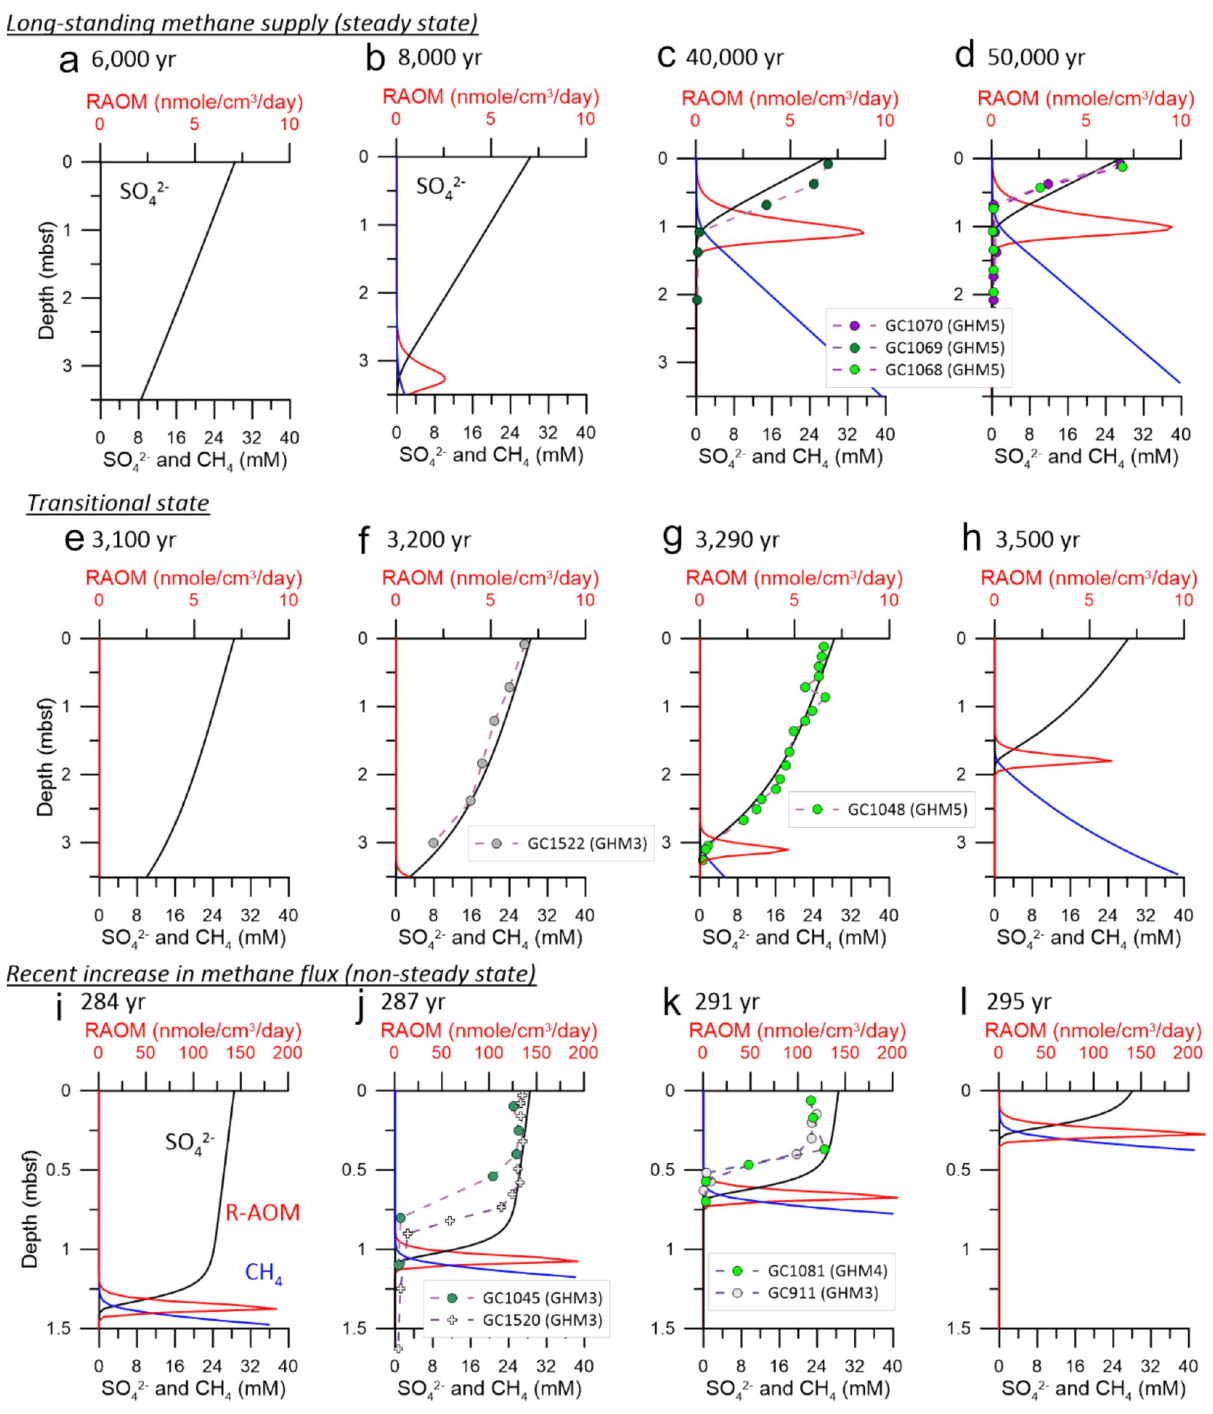
Fig. 2 Time-progressing reactive-transport modeling of porewater geochemistry under three states of methane dynamics. States include a long- standing steady-state methane supply ( a – d ), a transitional state ( e – h ), and a recent increase in methane fl ux (i – l). Porewater sulfate concentrations are shown as black lines, methane concentrations as blue lines, and rates of AOM (RAOM) as red lines. Data from gravity cores (GCs) are shown for the upper few meters below sea fl oor (mbsf). Porewater data from GHMs representing different methane states (GHMs 3 & 4, recent methane fl ux increase; GHM5, steady state) were shown for comparison, with colored points representing cores fi rst described in this study and gray points representing previously described cores (see Fig. 1 for site locations). a – d With a long-standing methane supply, the porewater sulfate pro fi le approaches a steady state after 40 kyr. The SMT gradually shoals with time (at a rate of 7E-3 cm/yr when comparing b and c ) with a linear decrease in downcore sulfate concentration resembling the pro fi les obtained from three gravity cores recovered at GHM5. e – h A transitional state occurs when the increase in methane supply is only moderate. i – l For a system experiencing a recent increase in methane supply, AOM stimulated by a recent pulse of methane rapidly changes sulfate concentration gradients as observed in sediment cores recovered from GHMs 3 &